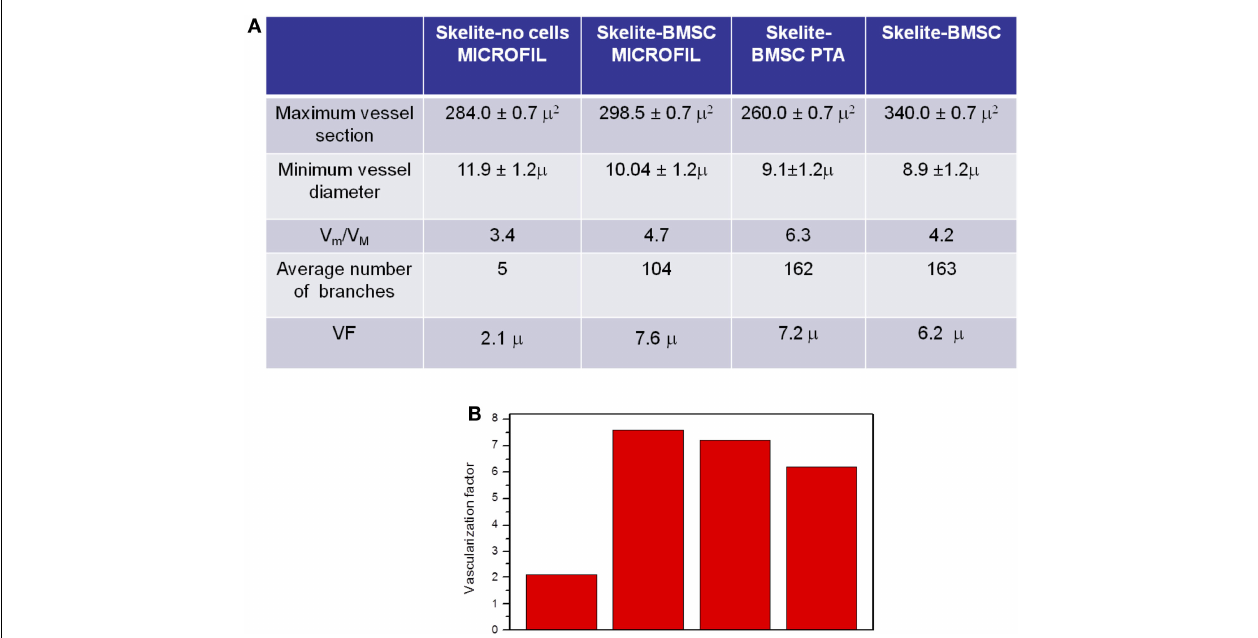
FIGURE 4 | (A) Table of quantitative information obtained for the A, B, C, and D samples. V m and V M are the total numbers of small and large vessels, respectively (see text). (B) Vascularization factor (see text) for the four samples.